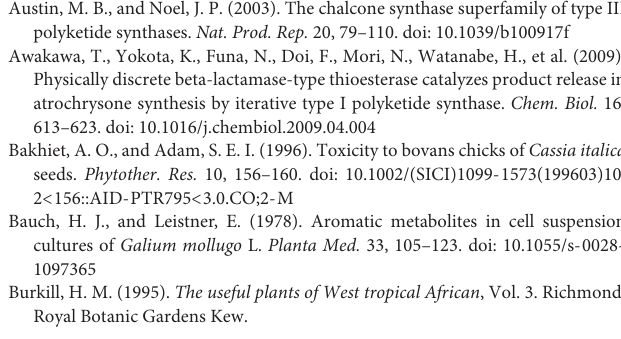
Supplementary Figure 1 | The length distribution of transcripts in S. occidentalis. Supplementary Figure 2 | The distribution of annotated unigenes using various public protein databases. Venn diagrams display the proportion of unigenes annotated using the NCBI Nr, KEGG, Swiss-Prot, and GO databases. Supplementary Figure 3 | Histogram of Gene Ontology classifications. The results are summarized in the three main categories: biological process, molecular function, and cellular component. Supplementary Figure 4 | Distribution of the transcription factor (TF) families in S. occidentalis. Distribution of transcripts (3,179 for RNA-Seq and 3,243 for Iso-Seq) that encode for TFs. Supplementary Figure 5 | Species distribution of the top BLAST hits. The most frequently hit species using the RNA-Seq and Iso-Seq datasets were calculated based on sequence alignments with the lowest E -value obtained from BLAST. Supplementary Figure 6 | Heatmaps representing the top 10 genes with tissue-specific expression in the S. occidentalis leaf, root, and young- and mature-stage seeds. Red and green represent high and low abundance, respectively. Supplementary Figure 7 | AgriGO analysis of the downregulated genes during seed development. The downregulated genes associated with molecular terms are represented by increasingly red colors. A Gene Ontology (GO) term enrichment analysis was performed using the single enrichment analysis (SEA) tool in AgriGO. Box colors indicate the levels of statistical significance: yellow = 0.05; orange = e–05; and red = e–09. Supplementary Figure 8 | AgriGO analysis of tissue-specific genes during seed development. Tissue-specific genes (A, leaf; B, root; and C, young_seed) associated with molecular terms are represented by increasingly red colors. A Gene Ontology (GO) term enrichment analysis was performed using the single enrichment analysis (SEA) tool in AgriGO. Box colors indicates the levels of statistical significance: yellow = 0.05; orange = e–05; and red = e–09. Supplementary Table 1 | Gene-specific primers used for tissue-specific qRT-PCR. Supplementary Table 2 | General properties of the reads produced using the Illumina HiSeq 2500 sequencing platform. Supplementary Table 3 | General properties of the reads produced using the PacBio sequencing platform. Supplementary Table 4 | Distribution of the tissue-enriched and tissue-specific transcription factors in each tissue. Supplementary Table 5 | Genes associated with the secondary metabolite pathway in S. occidentalis. Supplementary Table 6 | Comparison of the number of genes involved in the anthraquinone biosynthesis pathway in S. tora and S. occidentalis